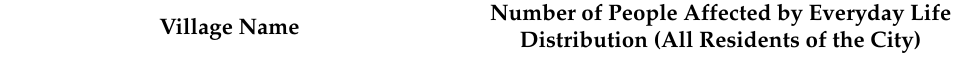
Table 10. Estimating of number of people affected by the everyday life distribution in the Bra´nszczyk